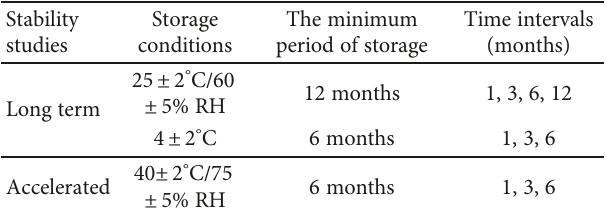
Table 2: Time intervals applied for stability studies